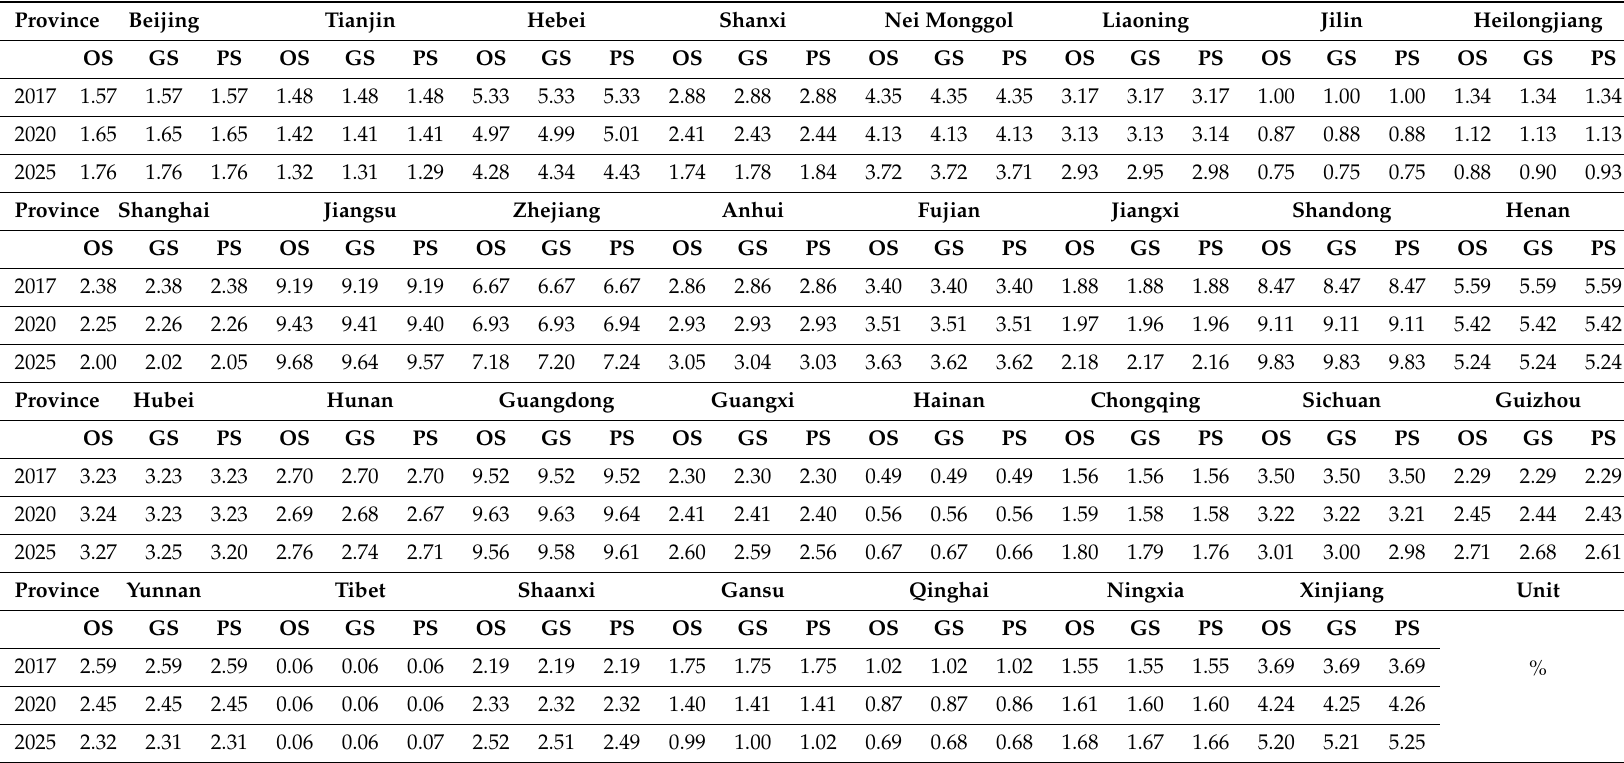
Table A6. Electric consumption share of each province under the three